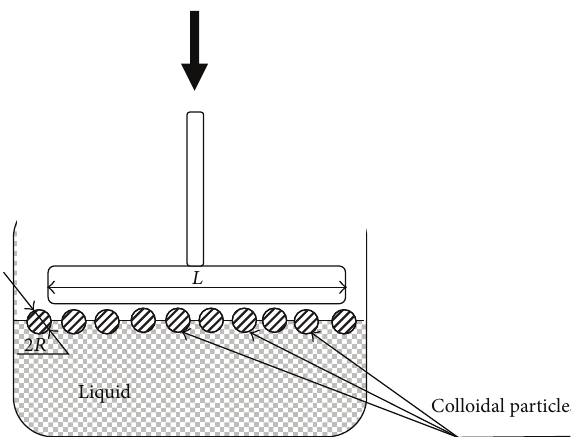
Figure 4: The transversal elasticity of a liquid surface, coated by the colloidal layer: the layer is pressed by a plate moving normally to the surface.